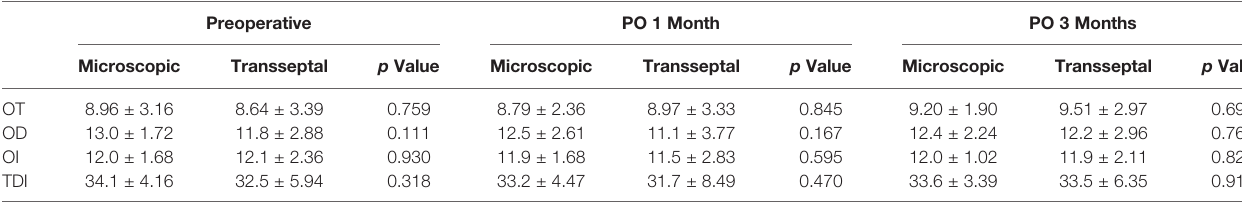
TABLE 7 | TDI scores of the Snif fi n ’ Sticks test.